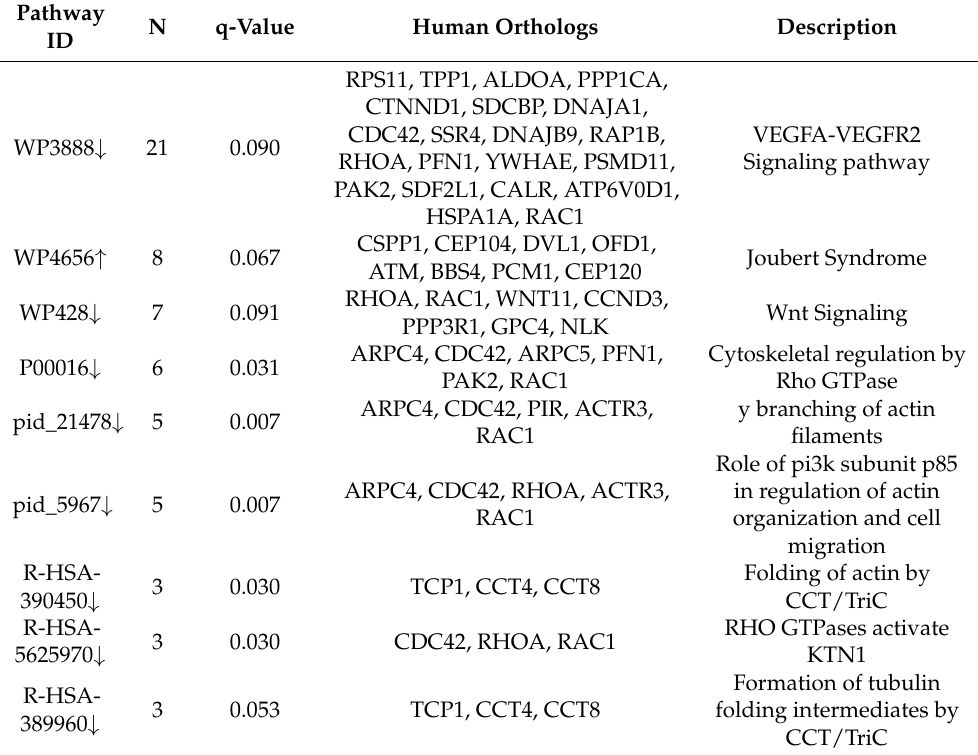
Table 4. Putatively downregulated (as indicated by a downward arrow) pro-fibrotic signaling pathways in the liver of NASH rats treated with the 9-strain